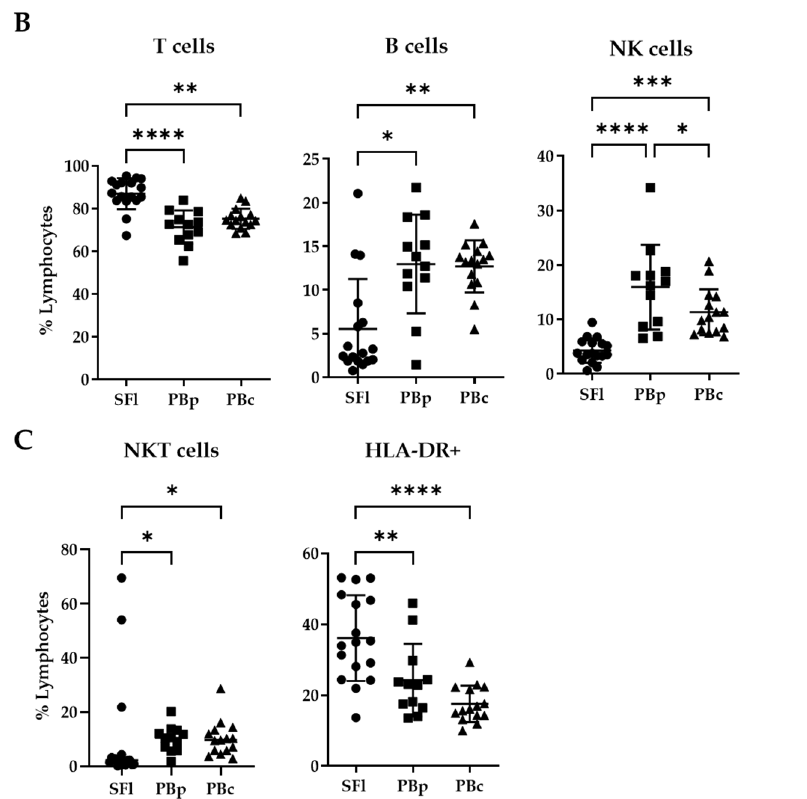
Figure 2. Lymphocyte composition of SFl and PBp/c by flow cytometry analysis. ( A ) Gating strategy of lymphocyte subpopulations in SFl and PBp after staining with panel 1; CD3+ T cells are depicted in blue, CD19+ B cells are shown in red, and NK cells in green. ( B ) Percentage of lymphocytes for CD3+ T cells, CD19+ B cells, and CD56/16+ CD3- NK cells. ( C ) Percentage of lymphocytes for CD56/16+ CD3+ NKT cells and activated lymphocytes (HLA-DR+); * p < 0.05, ** p < 0.01, *** p < 0.001, **** p < 0.0001.